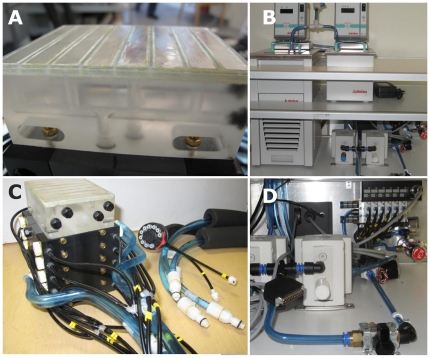
The thermal grill-unit.
Panel A) Detail of the surface of the thermode, consisting of eight silver bars each measuring 11 mm×80 mm. The bars were mounted onto a Perspex-block bringing odd and even numbered bars into direct contact with (potentially) different pools of circulating water. Channels drilled through the Perspex-block connected to the inlet/outlet unit (grey-colored block) through the bottom of the thermode. Panel B) Water baths for cooling and warming, connected to a circulation pumps. Panel C) The TGI-thermode attached to the grey Delrin inlet/outlet unit. The Delrin-block has bored channels in which ten pneumatically operated piston-valves operate. The two segregated pools of warm- and cold-water are continuously circulated through the unit (blue hoses). The position of the valves, set through computer controlled pneumatics (thin black tubes), determine the water-flow to the Perspex-block thermode. The thermode and inlet/outlet unit are connected to the baths, pumps and control devices through a thermally insulated umbilical-cord running through the radiofrequency wave-traps of the MRI-Faraday cage. Panel D) Pressurized air-operated process pumps for circulating the water, along with computer-controlled pneumatic switches – allowing precise timing of stimulus-presentation.